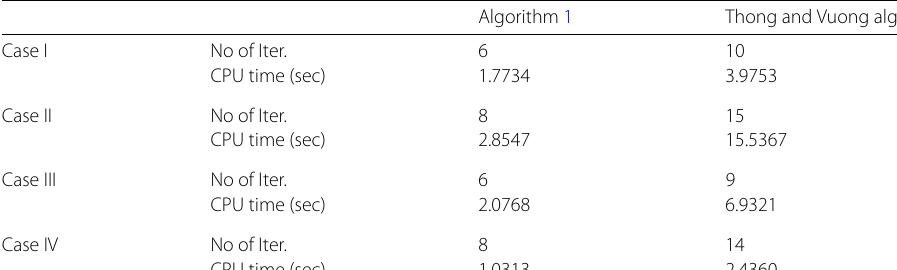
Table 2 Computation result for Example 5.2